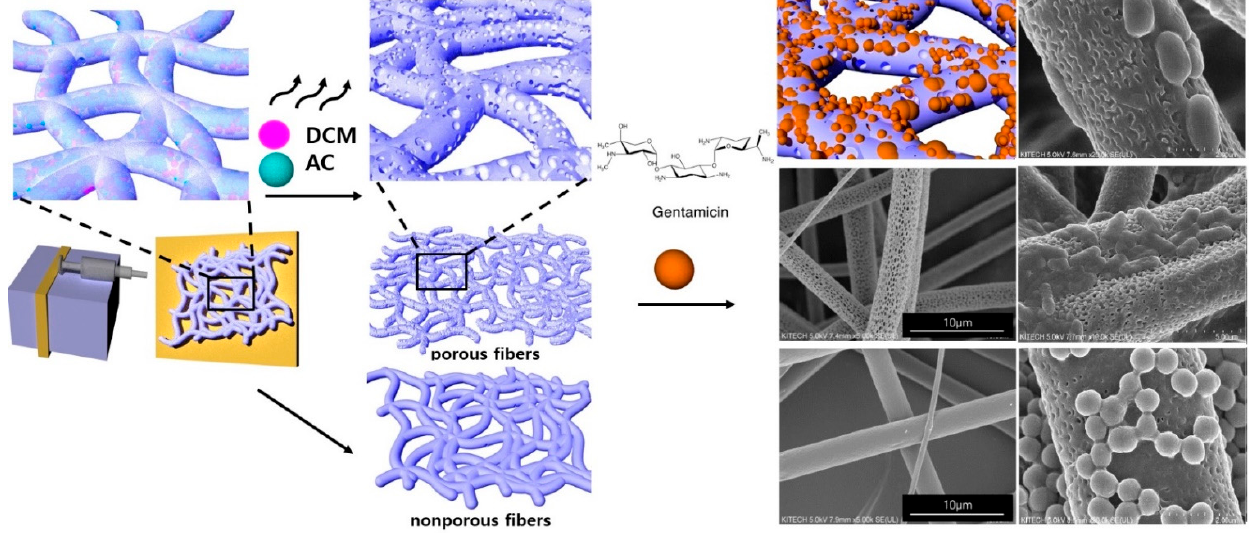
Figure 1. Scheme of pore formation in electrospun porous and nonporous PLA fibers by liquid–liquid phase separation method and antibacterial PLA microfibers.